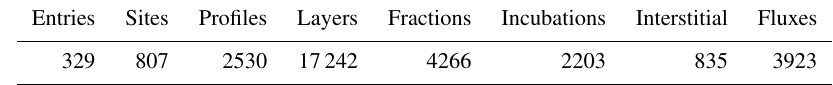
Table 1. The number of data points currently included at each hierarchical level in ISRaD v1.2.3.2019-12-20 Entries